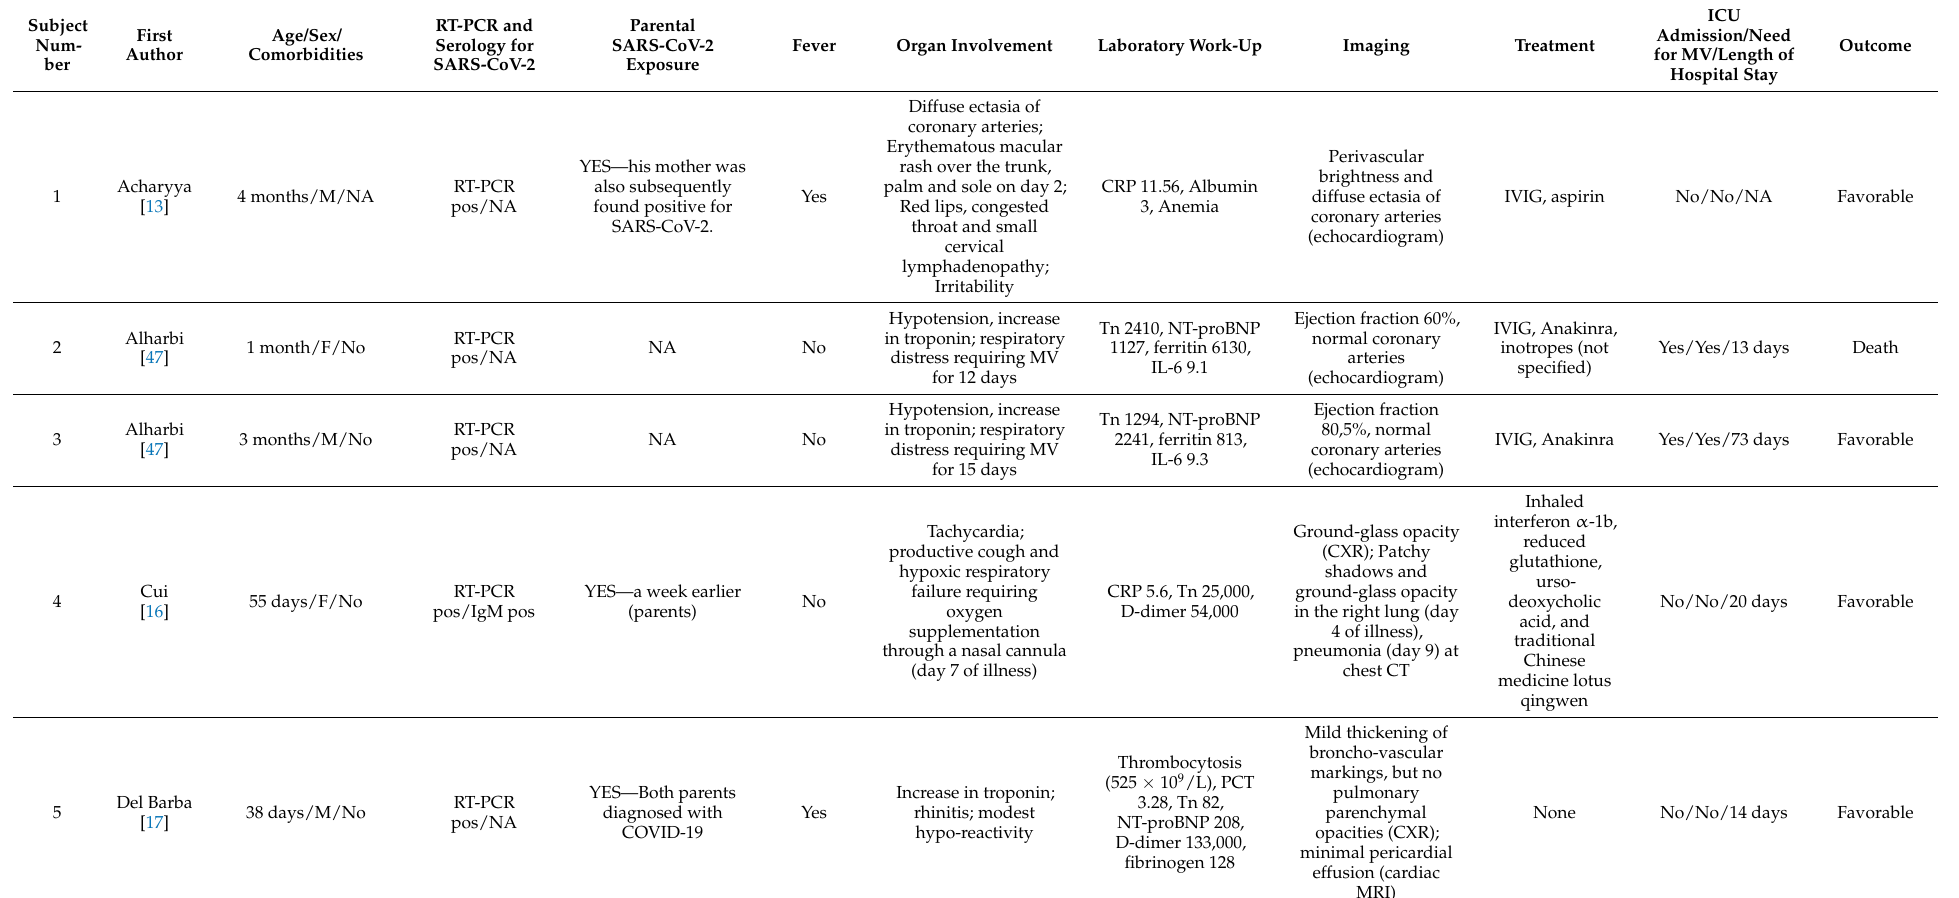
Table 3. Characteristics of neonates and infants under six months of age with MIS-C with fully described